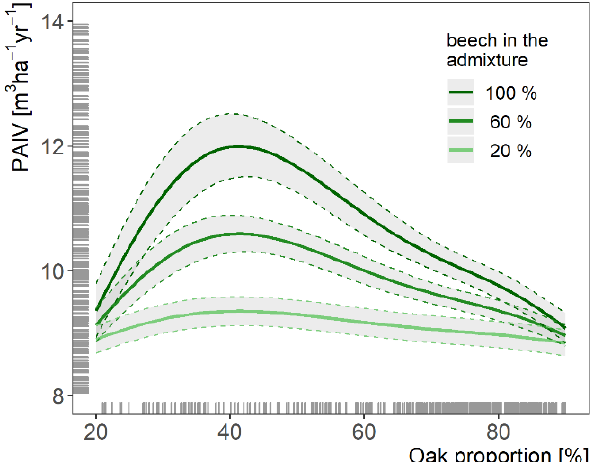
Figure 3. Non-linear smooth functions (GAMM) of stand productivity for mixed oak stands as a function of oak proportions and proportion of beech in the admixture; rugs on the x-and y-axis indicate the observed values of oak proportions and stand productivity, respectively; for the underlying model statistics we refer to the supplementary material (Table S4).